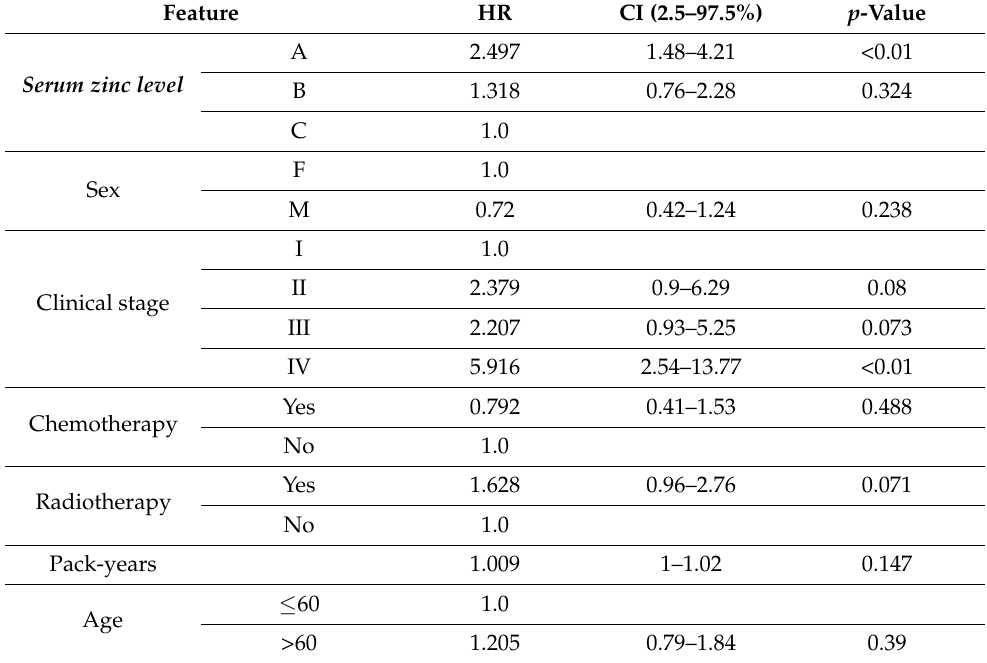
Table 7. Multivariable Cox regression (SOD 2 TC/TT or CAT CC , n = 260).